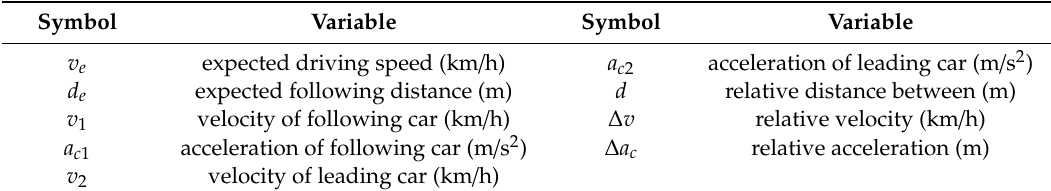
Table 1. Variables and symbols.